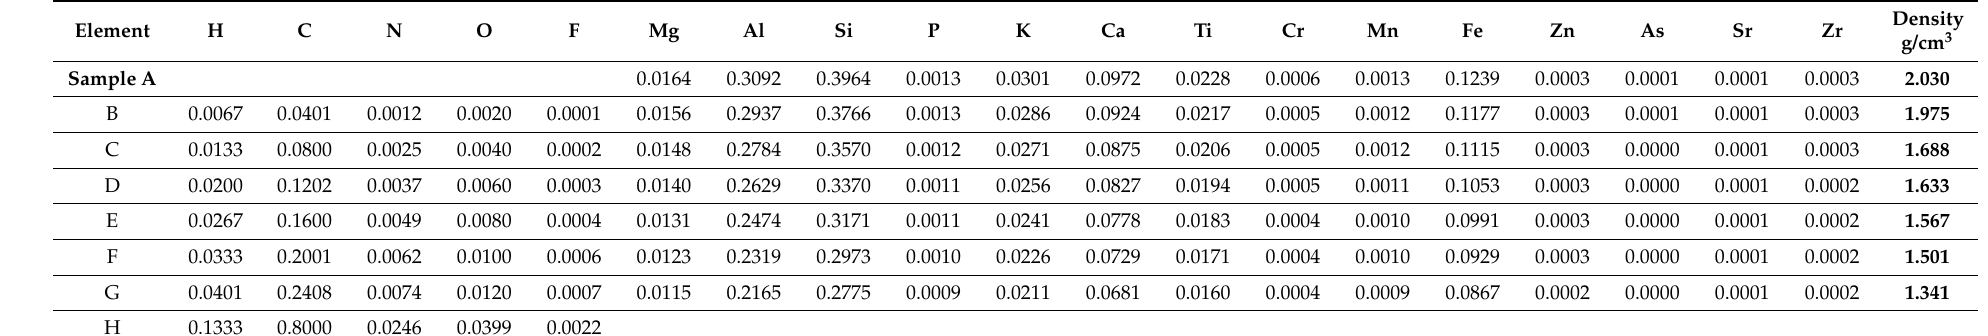
Table 4. The weight fraction of each element in the samples and density of each of the